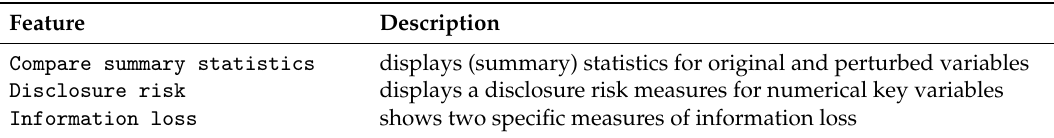
Table 9. Risk measures and information for numerical key